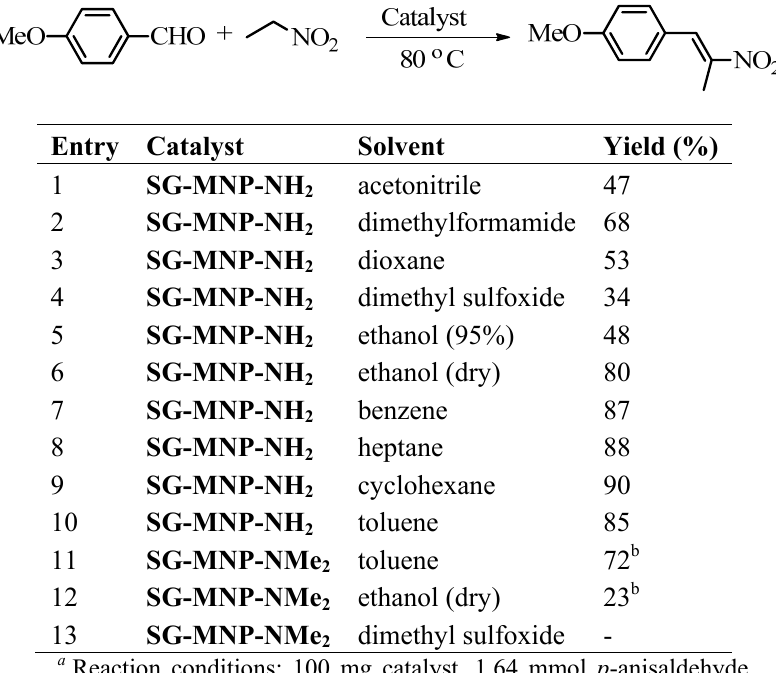
Table 1. Nitroaldol condensation of nitroethane with p -anisaldehyde in different organic solvents catalyzed by magnetically separable heterogeneous base catalysts a